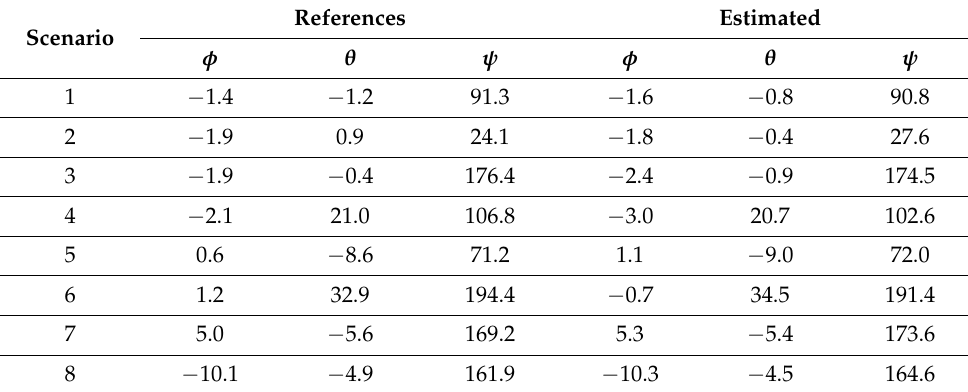
Table 2. Mean error in fine alignment process.